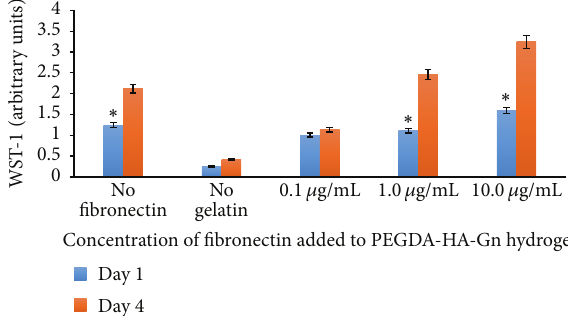
Figure 4: Proliferation of hDPSC in PEGDA-HA modified hydro- gels with different concentrations of fibronectin. 𝑛 = 3 samples. WST-1 was used to determine the relative cell densities at days 1 and 4. ∗ 𝑝 < 0.05